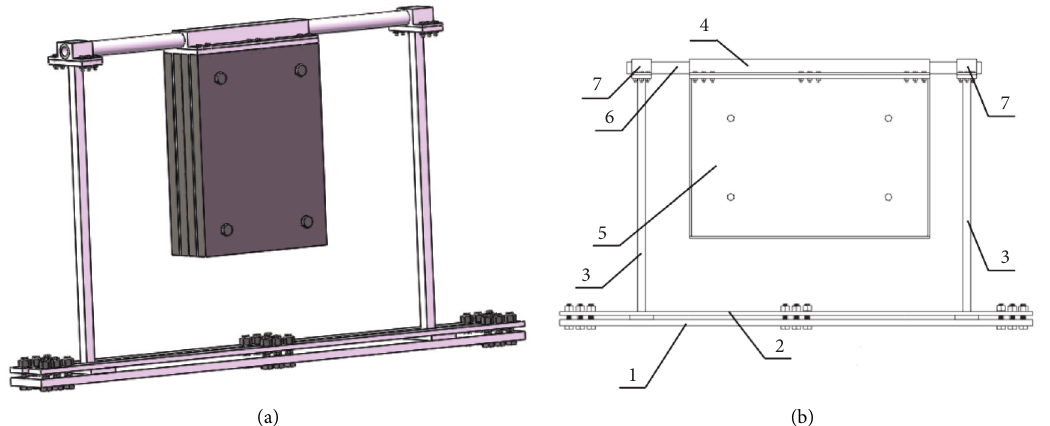
Figure 1: Schematic of the FATMD. (a) Three-dimensional schematic, (b) elevation drawing. 1—bottom plate; 2—pressure plate; 3—column; 4—weighted box; 5—counterweight steel plate; 6—Beam; and 7—column fastener.